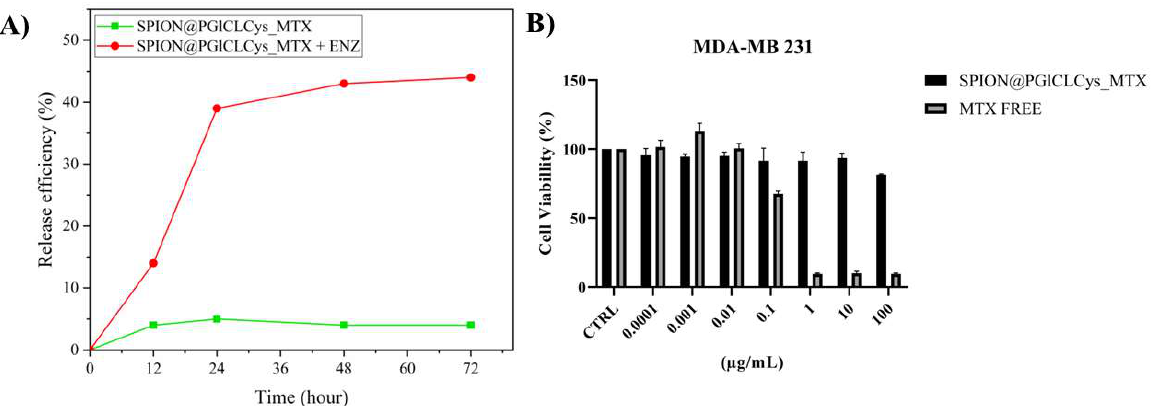
Figure 3. SPION@PGlCLCys_MTX: ( A ) drug delivery assay at lysosomal pH (pH 5.3) with or with- out protease (ENZ); ( B ) breast carcinoma-derived MDA-MB 231 cells viability after 72 h at different MTX concentrations.